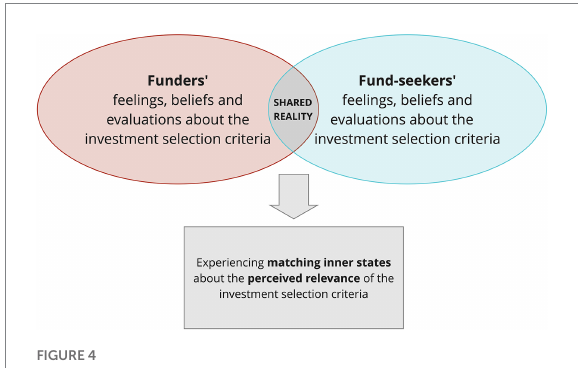
FIGURE 4 The experience of shared reality in a dialogue between funders and fund